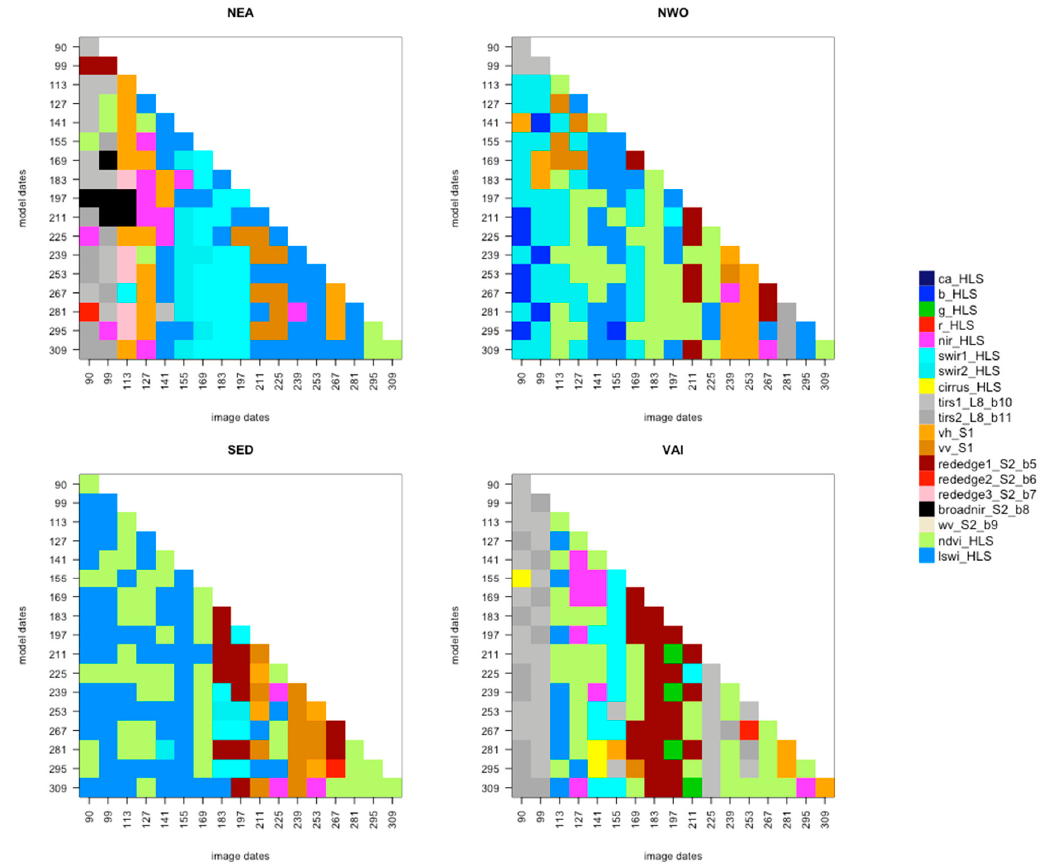
Figure 8. The summary of the highest ranked parameter (band) across the four case study regions over time. For example, on DOY 127 following bands can be seen as highest ranked for the given regions: NEA VH and NIR-HLS; NWO SWIR1-HLS, NDVI-HLS, and VV; SED NDVI-HLS and LSWI-HLS; and VAI NIR-HLS, NDVI-HLS, and LSWI-HLS.